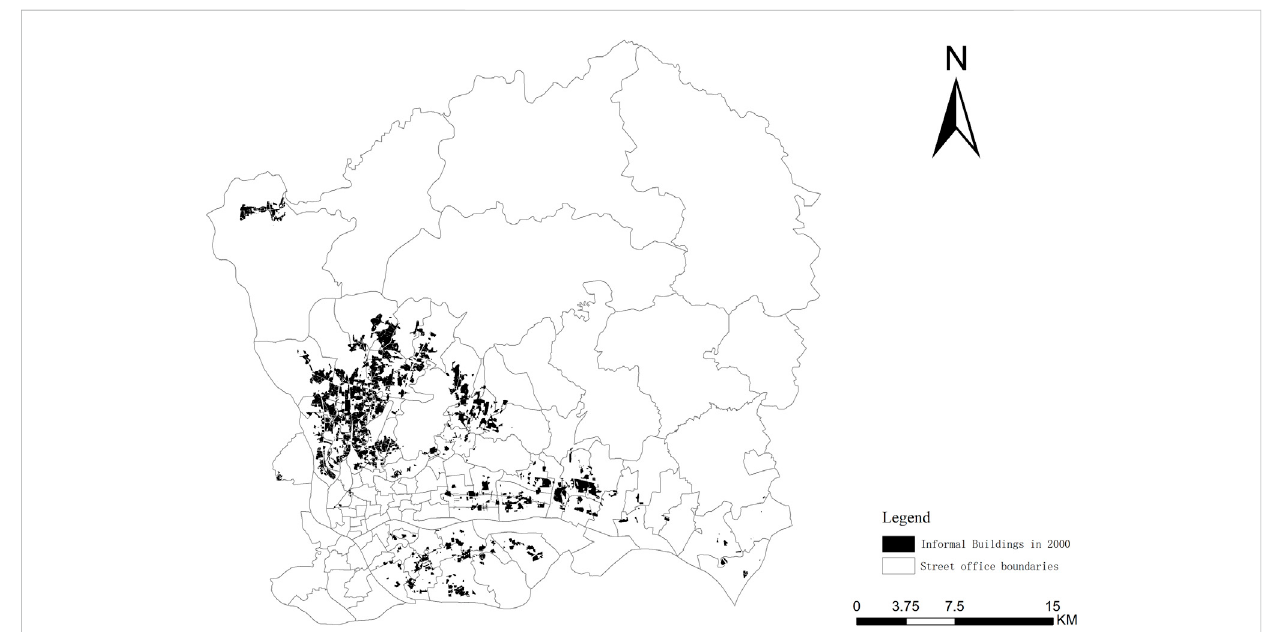
FIGURE 4 Spatial Distribution of urban villages in 2000(Source: Drawn by the authors).